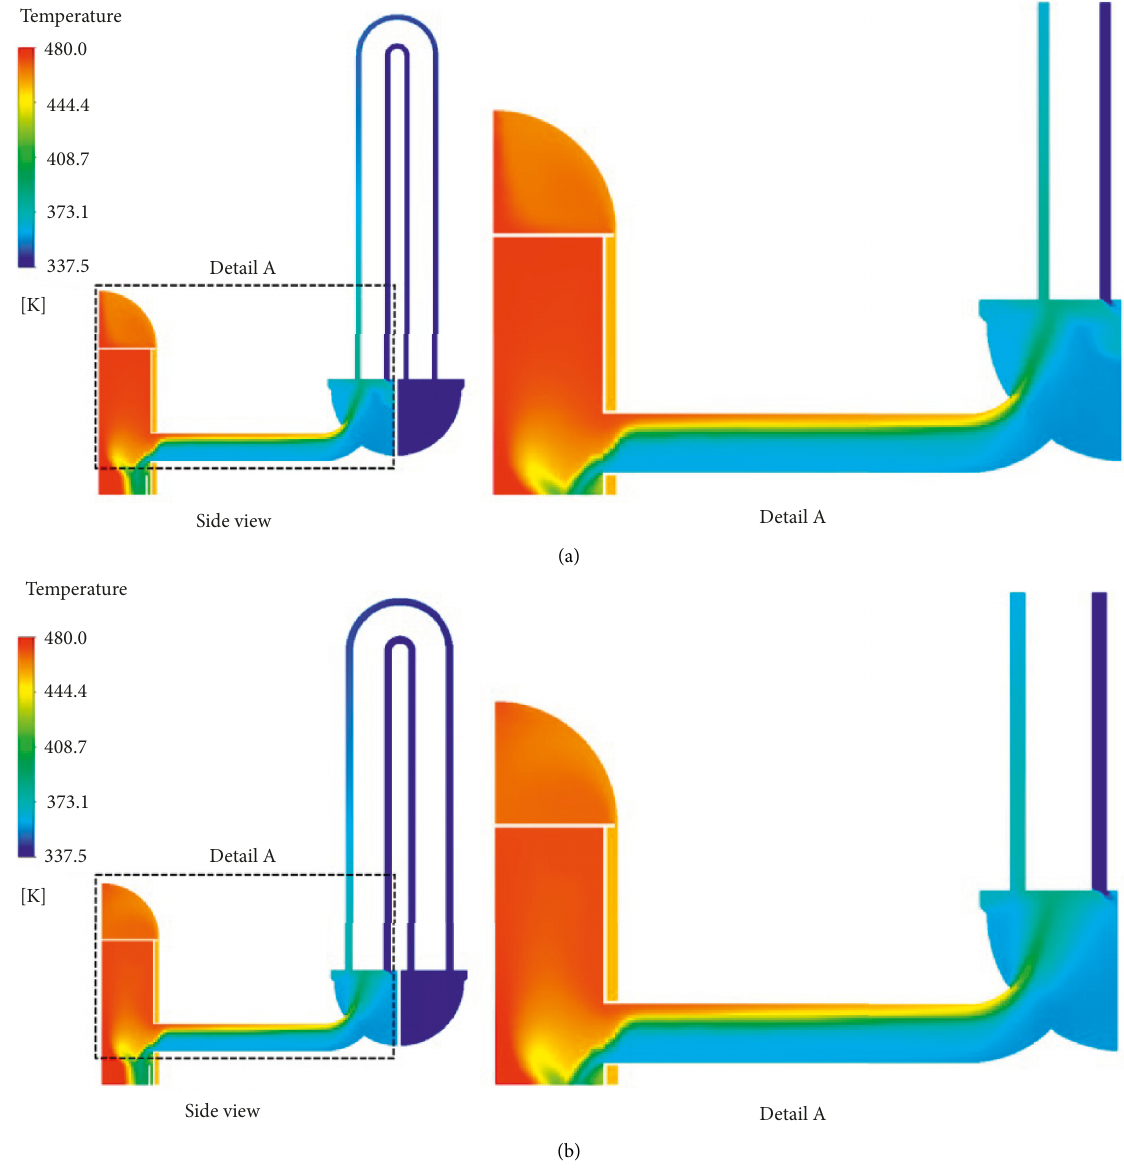
Figure 12: Temperature distribution on symmetry plane (models 2 and 3). (a) Model 2 and (b) model